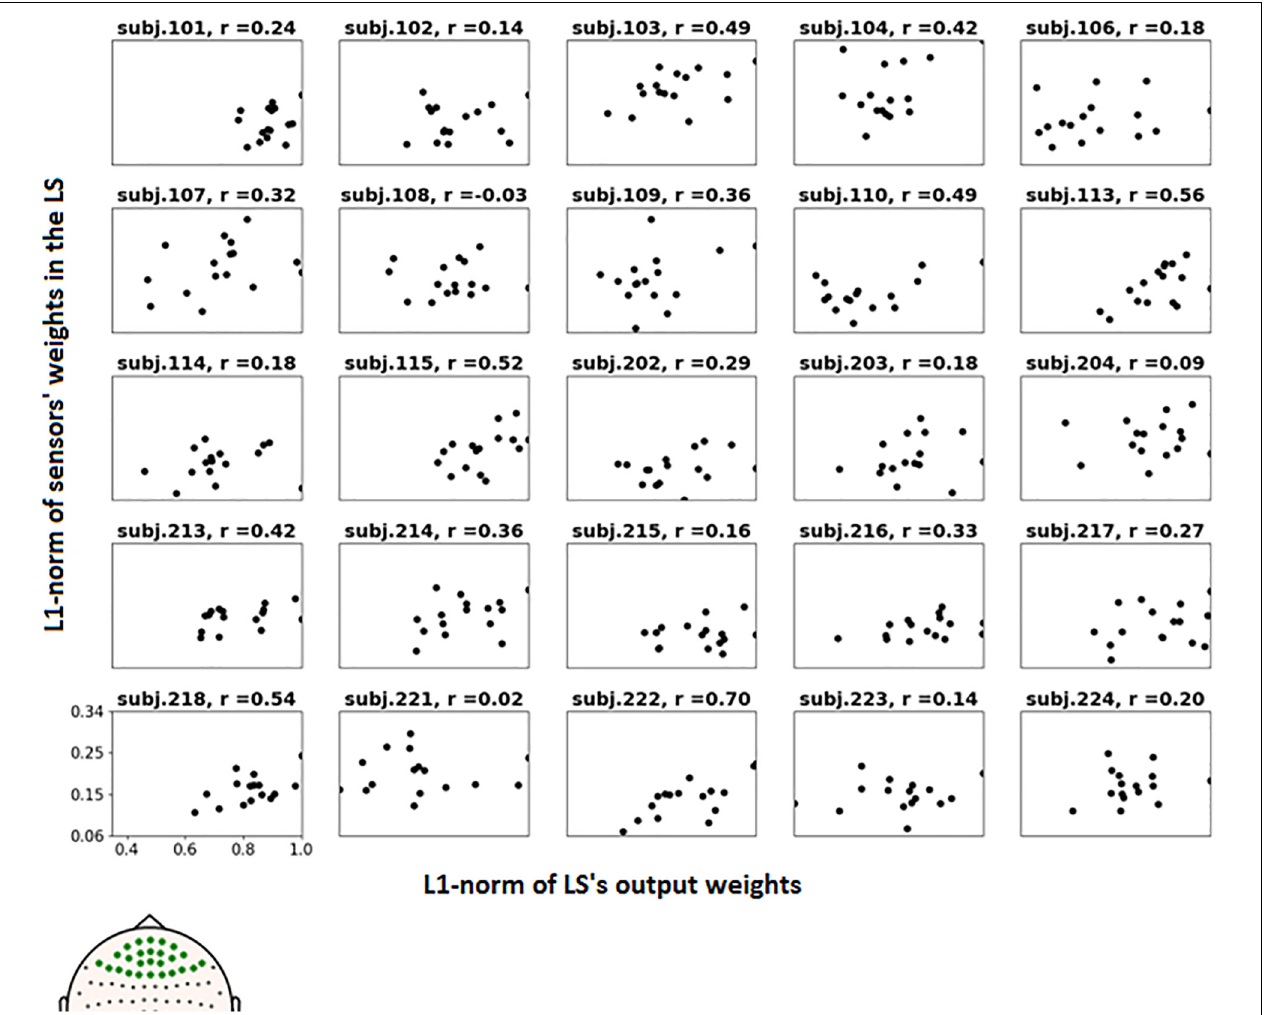
FIGURE 9 | Dependence of the L1-norm of LS frontal sensor weights on L1-norm of LS output weights for the voluntary class. Each picture corresponds to a single participant, dots correspond to LSs. Positions of the frontal sensors (presumably most vulnerable to the eye movement), whose weights were averaged, are shown in bold on the head map in the left bottom